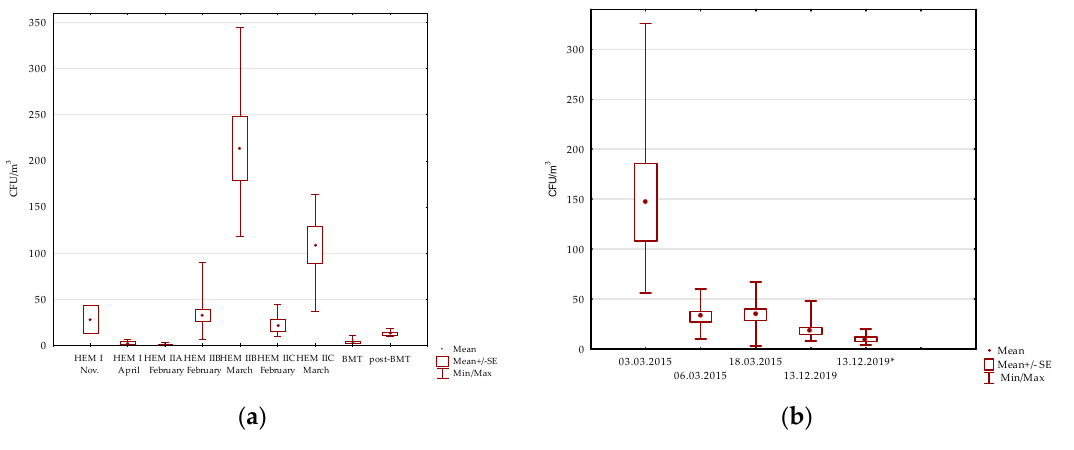
Figure 1. Concentrations of fungi (CFU/m 3 ) in the air of patient rooms in hematological wards ( a ) and in patient rooms and bathrooms (13.12.2019; marked with an asterisk) in hospitals for lung diseases ( b ). The graphs show mean values of CFU/m 3 as well as standard errors (SE) and minimal and maximal values obtained for particular hospital wards listed in Tables 1 and 2. Table 2. Concentrations of fungi in the air of the hospital for lung diseases.